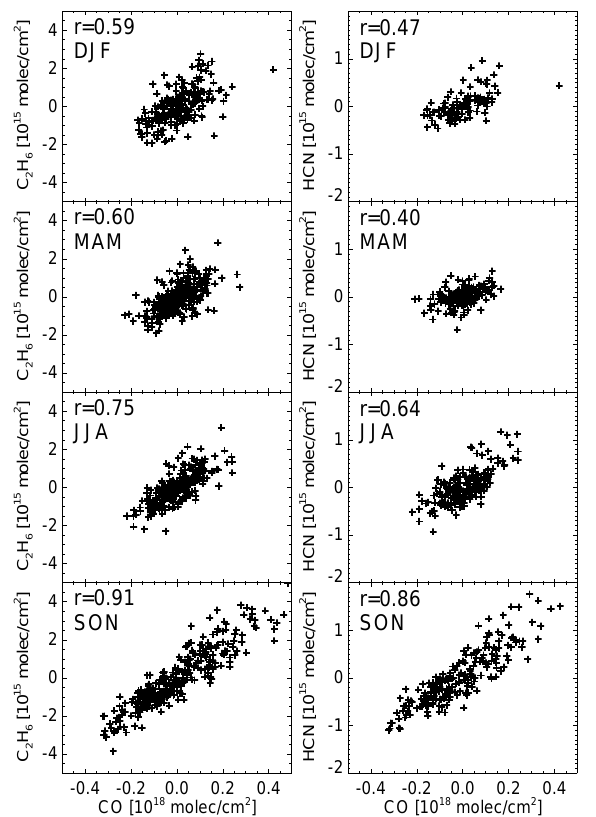
Fig. 3. Tracer-tracer correlative scatter plots for C 2 H 6 and CO, and for HCN and CO, respectively, at Lauder for the four seasons. r indicates Pearson’s correlation coefficient. All variables have been deseasonalized and